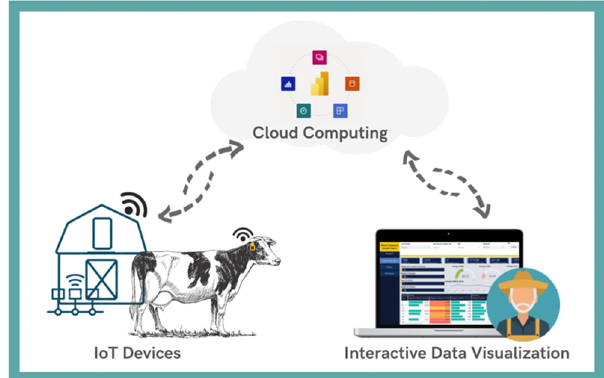
Figure 4. Smart Livestock Monitoring System concept.